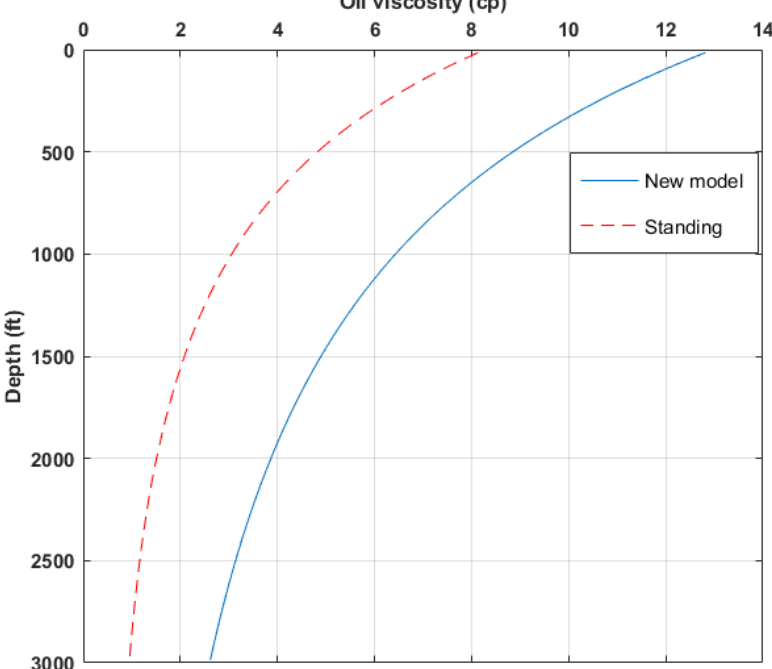
Figure 9. Oil viscosity as a function of Standing model and the new correlations.